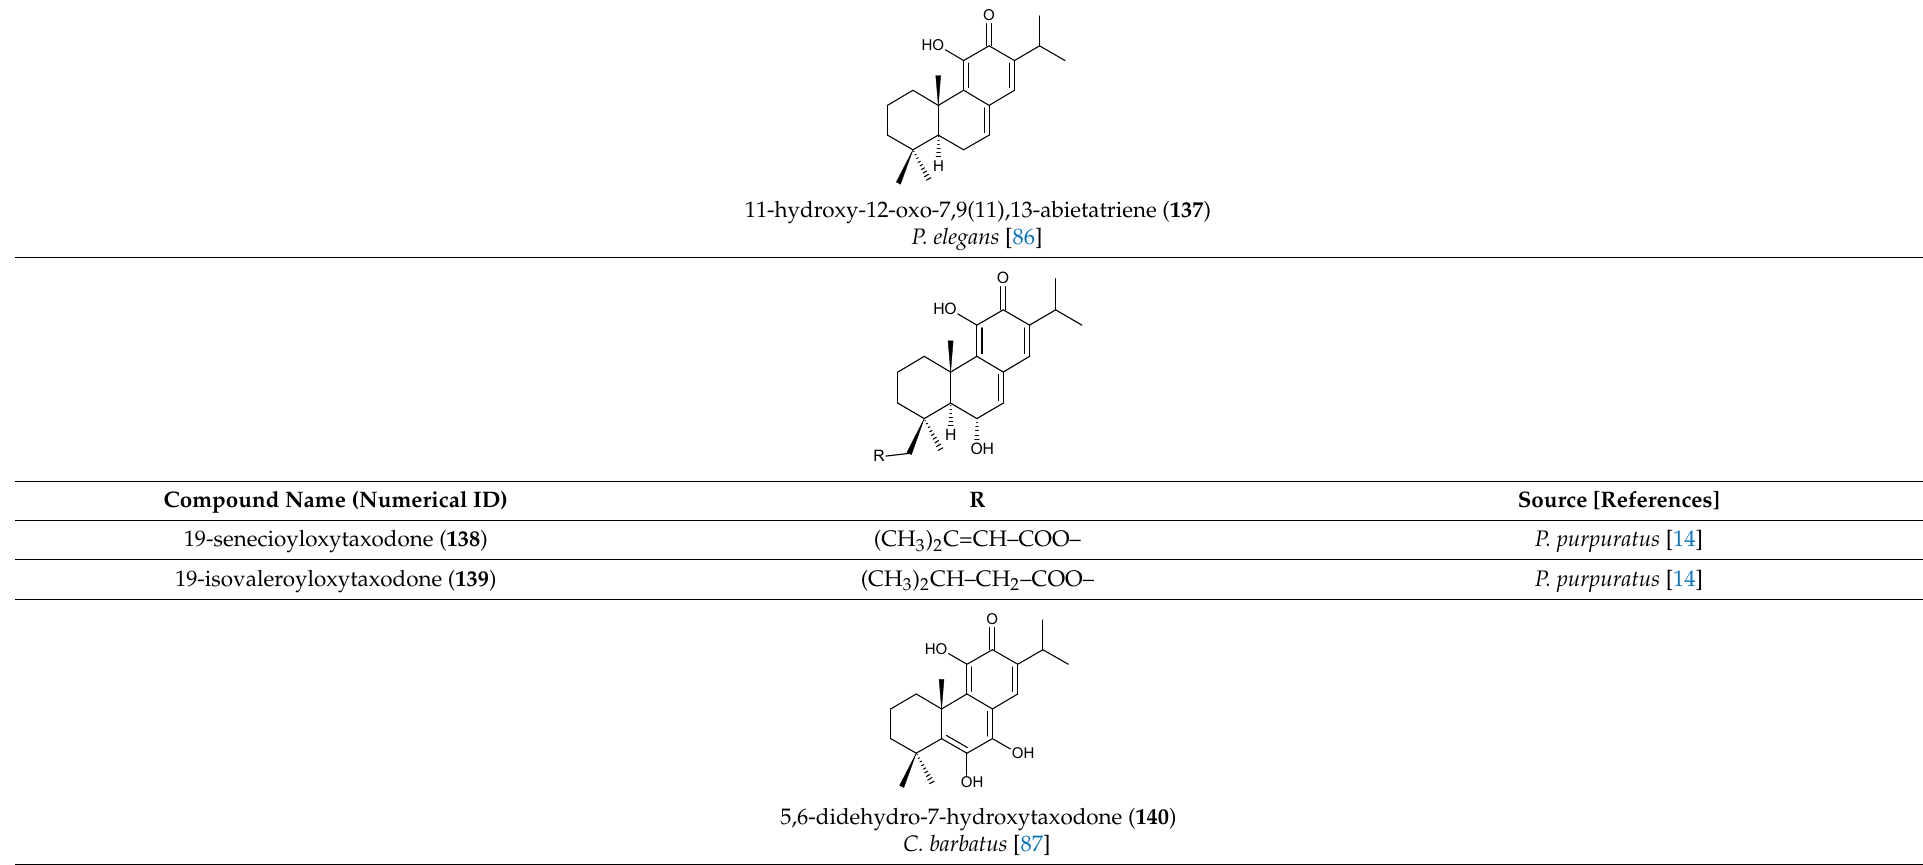
Table 3. Quinone methides of the genus Plectranthus s.l.